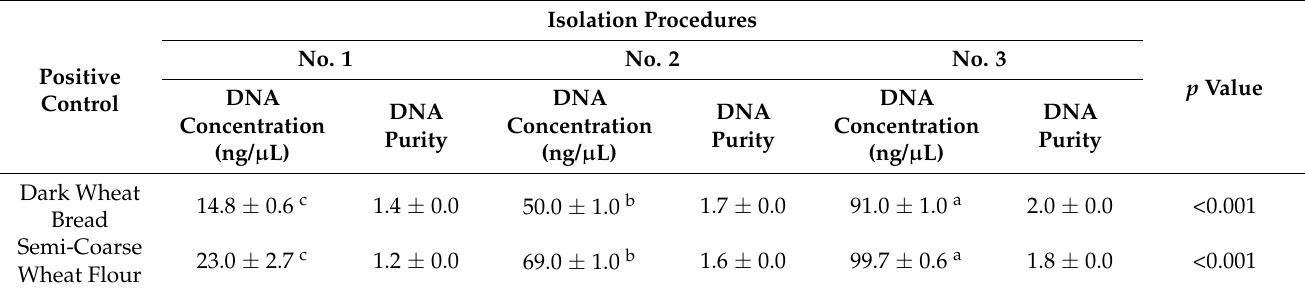
Table 1. Means and their standard deviations (SD) of the concentrations of isolated DNA samples from positive controls obtained by three isolation procedures. Isolation Procedures ValueNo.